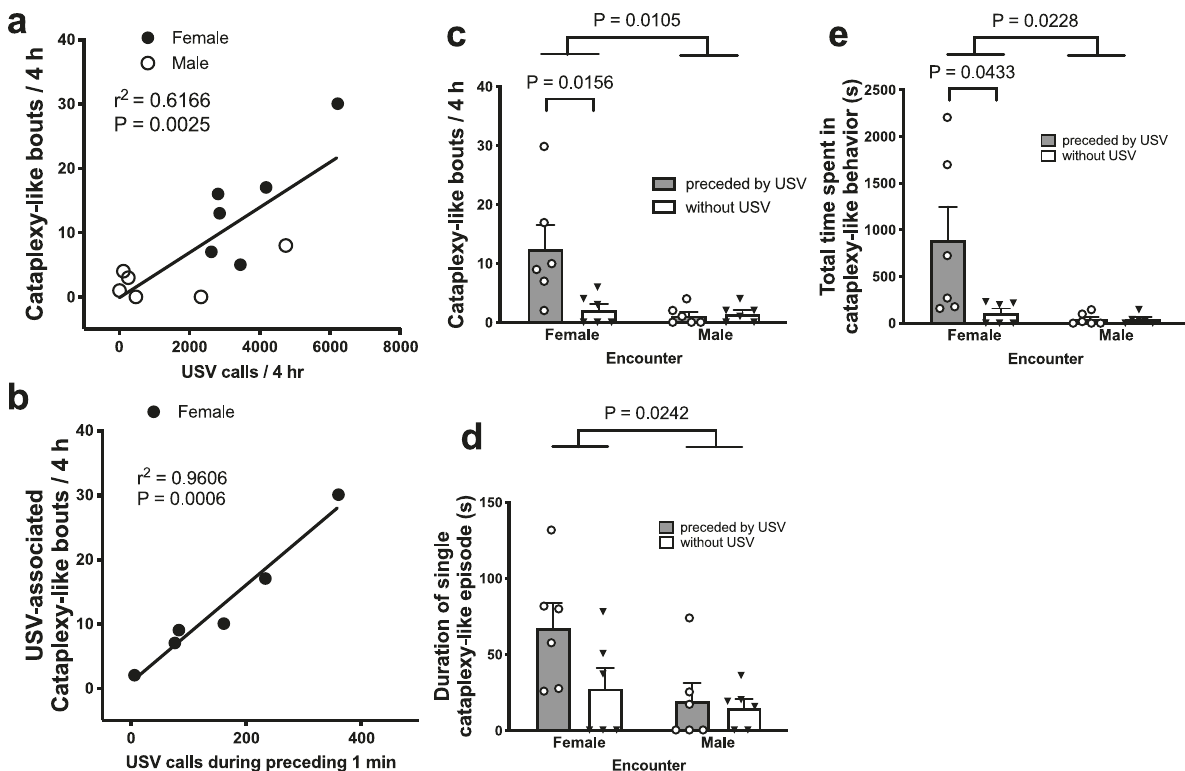
Fig. 3 Relationship between cataplexy and ultrasound vocalizations. a Correlation analysis between the number of ultrasound vocalization calls (USV) and the number of cataplexy-like bouts showed a positive correlation between the two. b Correlation analysis between the number of calls during the 1 min preceding cataplexy and the number of USV-associated cataplexy-like behavior. A much stronger correlation was observed than in a . Characterization of the number ( c ), duration ( d ), and total time ( e ) of cataplexy-like bouts. These parameters are classi fi ed according to the sex of the mouse encountered and whether it is preceded by USVs within 1 min before the onset of cataplexy-like behavior. Data are expressed as mean ± SEM of six ORX-AB mice. Each animal was tested twice (with female and male). P values in the fi gure were obtained using two-way ANOVA and following Sidak ’ s multiple comparison